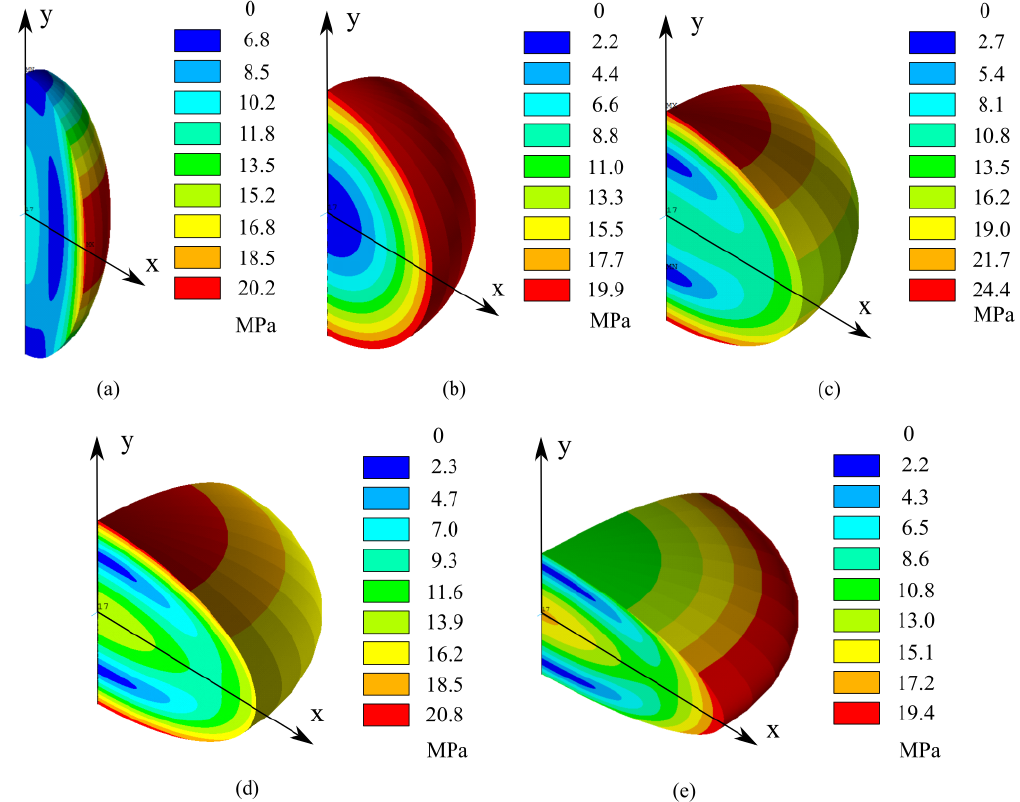
Figure 10. Von Mises stress (MPa) in geometries with different aspect ratio: ( a ) α = 0.5, ( b ) α = 1, ( c ) α = 1.5, ( d ) α = 2 and ( e ) α = 2.5. Chemical and mechanical properties are listed in Table 2, lithium flux is 1 A/m 2 , simulation time is 1000 s.